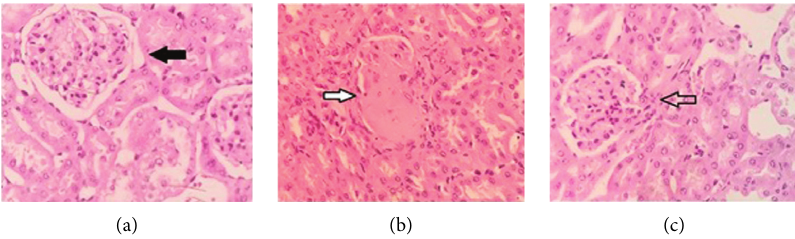
Figure 5: Hematoxylin- and eosin-stained sections of the kidney tissue ( × 400). (a) Kidney from normal mice showing normal glomeruli (black arrow), (b) kidney from diabetic mice showing the structural disorganization in glomeruli (white arrow), and (c) kidney from S. spinosa (200 mg/kg)-treated diabetic mice showing almost normal morphology.